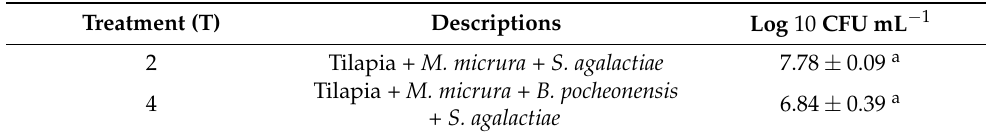
Table 4. Bacterial counts on tilapia larvae fed with unenriched and enriched Moina micrura after challenged with Streptococcus agalactiae .